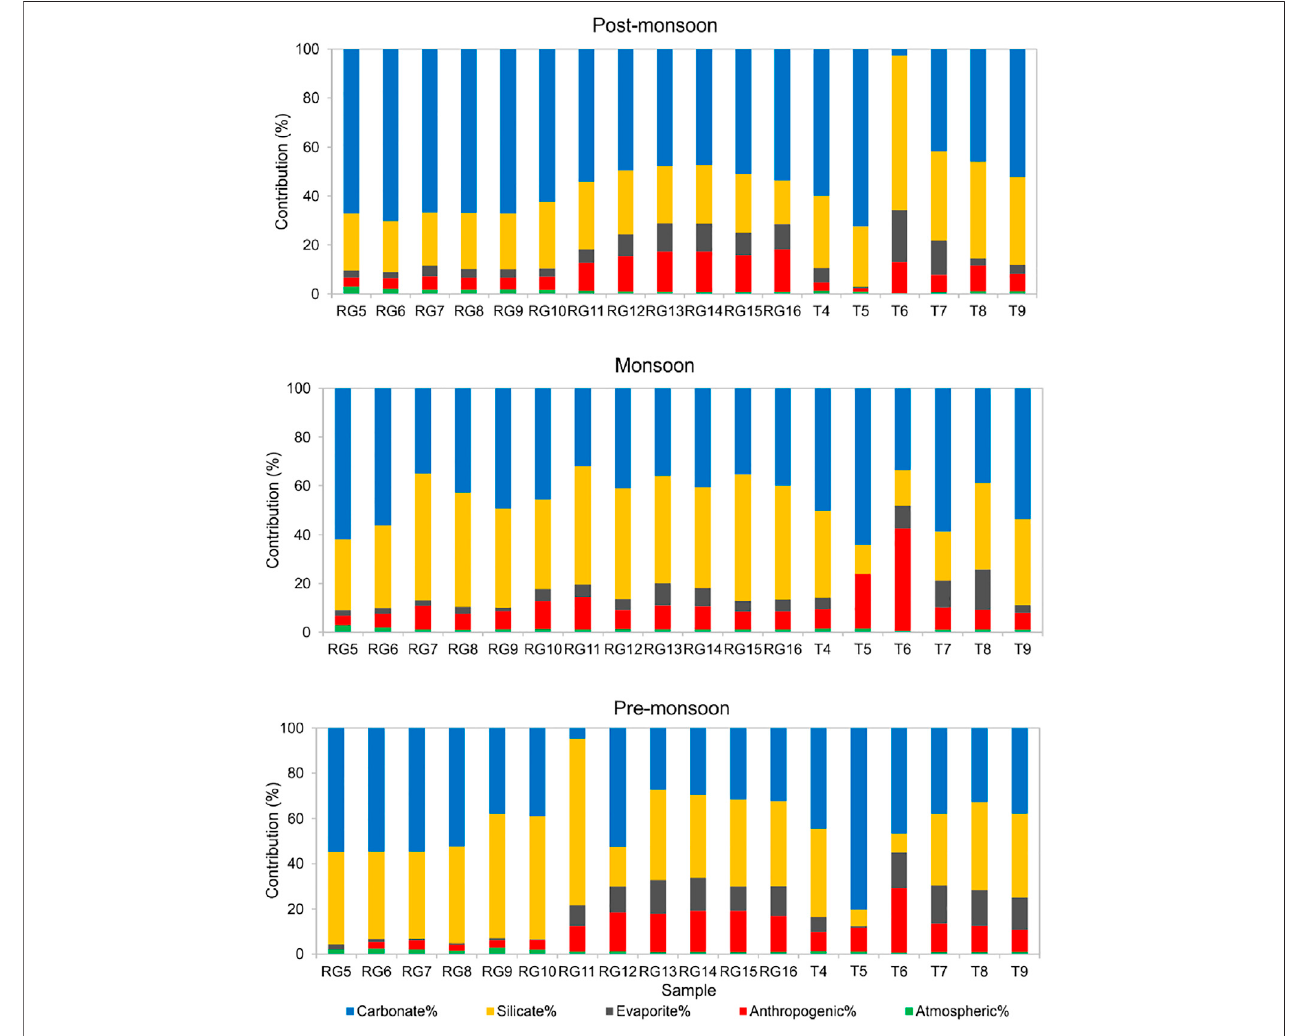
FIGURE 7 | Contribution of different sources to major cation load in pre-monsoon, monsoon, and post-monsoon seasons in fl oodplain region (Zone 2).